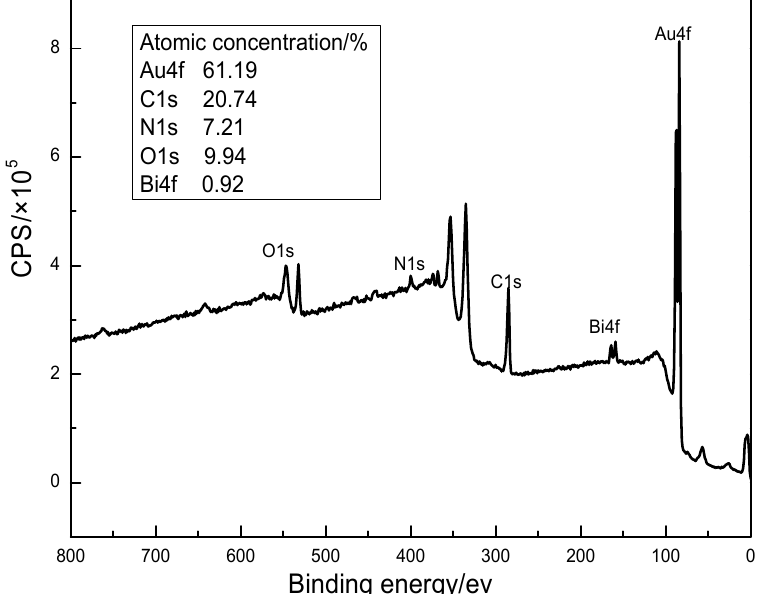
Figure 6. XPS full spectrum of gold surface products in conventional cyanide system. Metals 2019 , 9 , x FOR PEER REVIEW